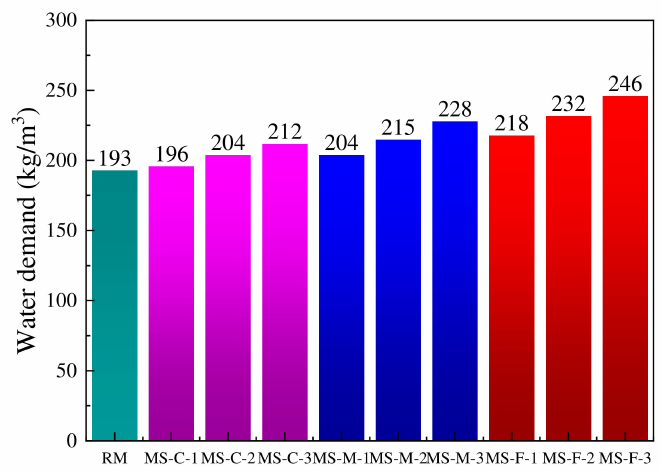
Figure 6. Water demand of each concrete